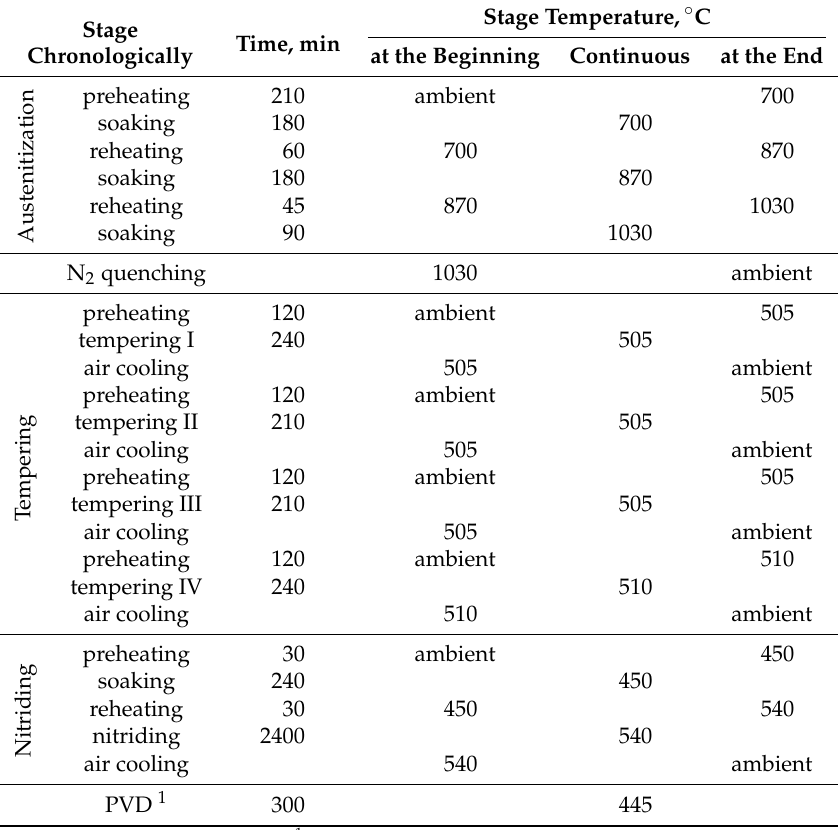
Table 1. Technological parameters of heat treatment of the K340/AlCrSiN samples. Stage Temperature, ◦ C Stage Time, min Chronologically at the Beginning Continuous at the